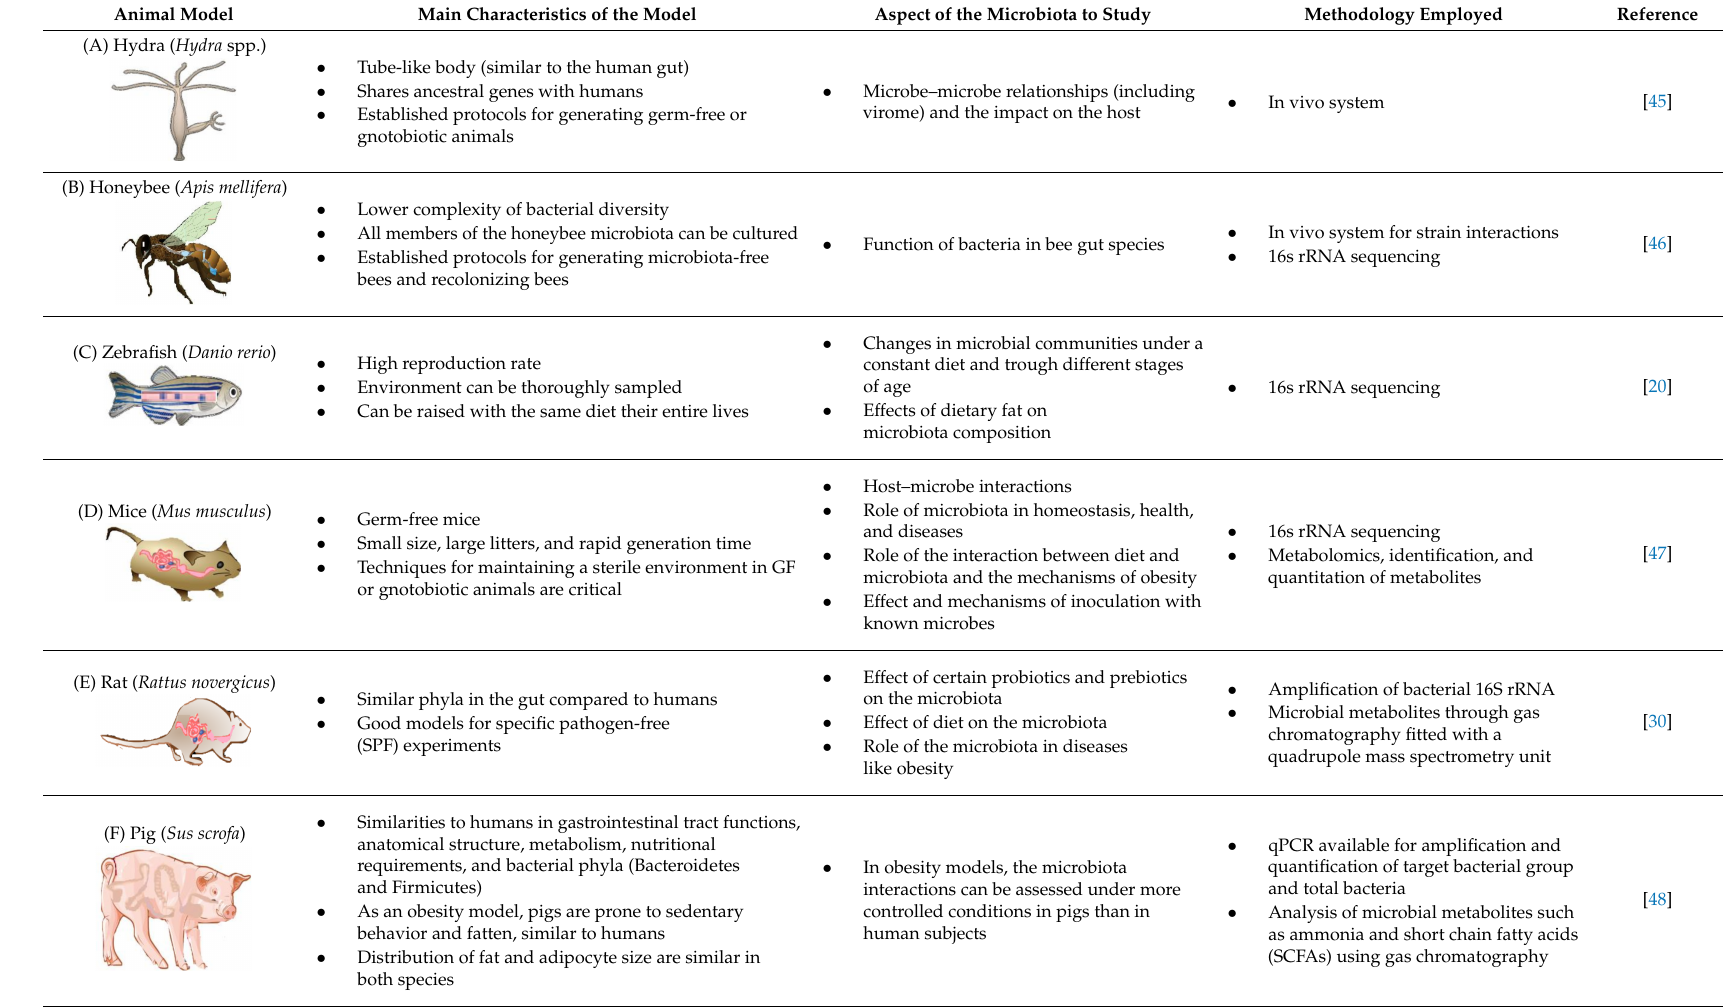
Table 2. Animal models for microbiota research (images from Creative